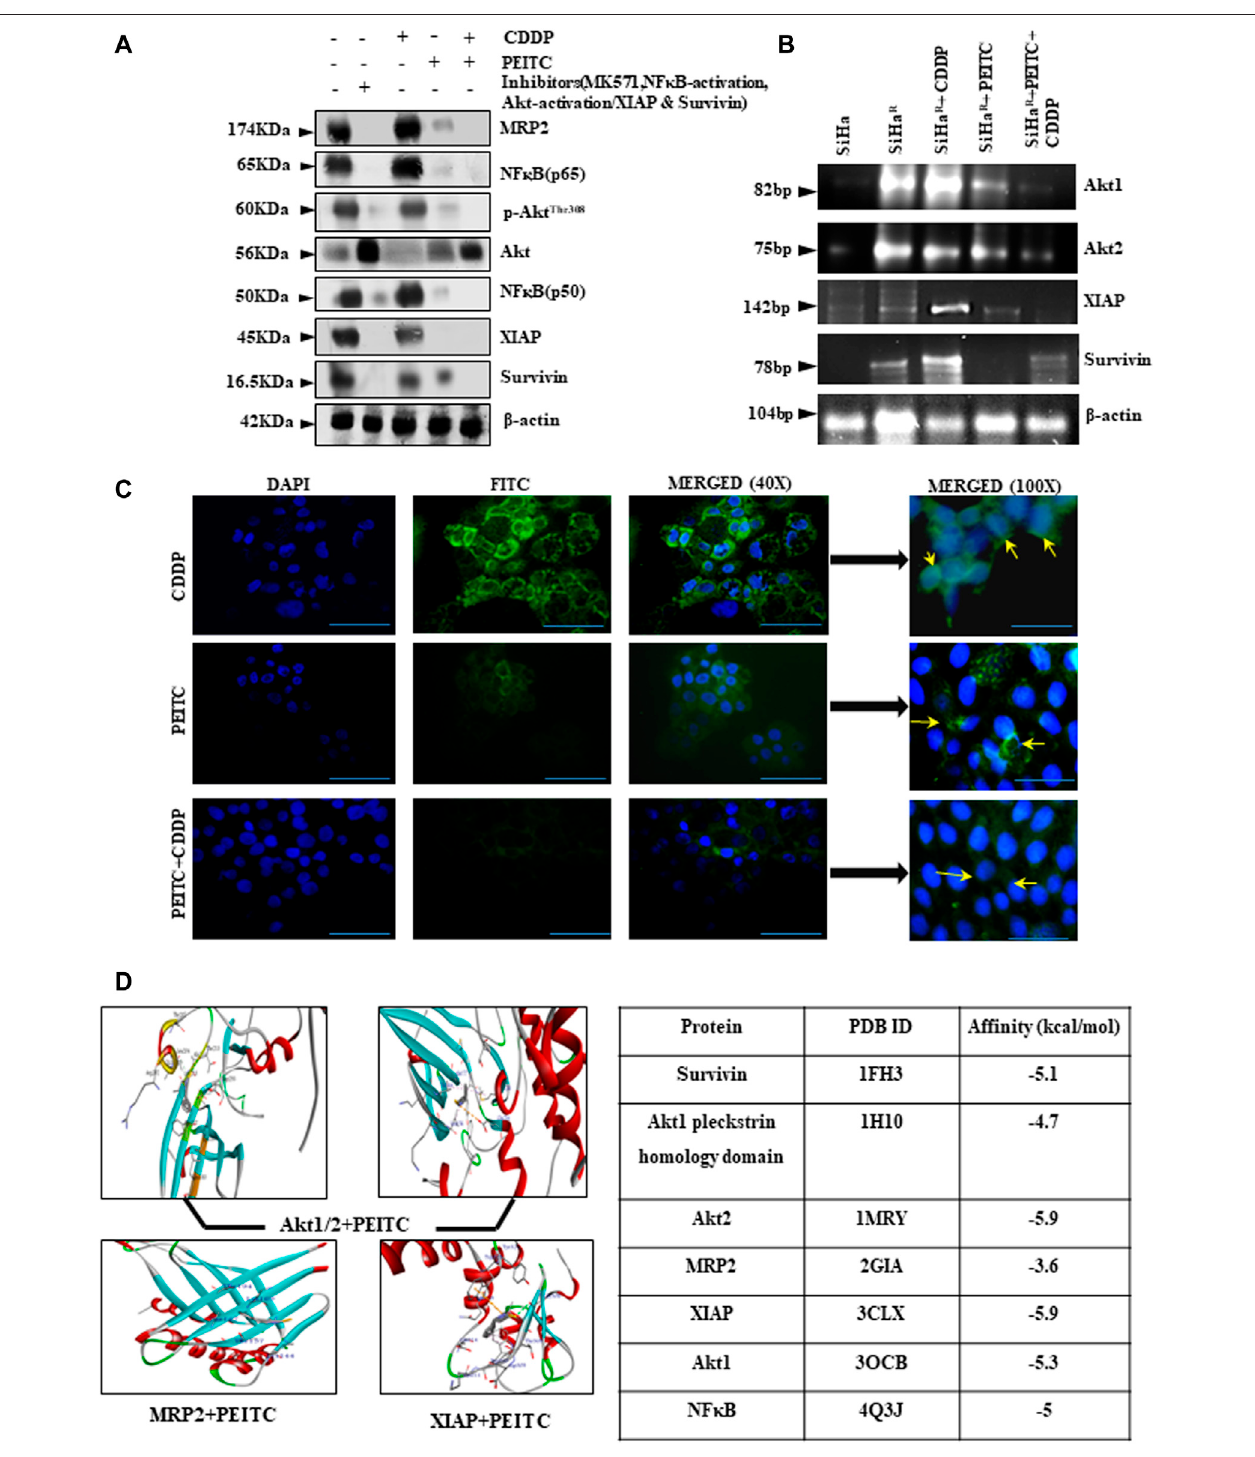
FIGURE 3 | (A) Relative protein expressions of Akt/p-Akt Thr308 , NF- κ B (p50/p65), MRP2, XIAP, and survivin by Western blotting. β -actin was used as a loading control.Respectivebandintensitiesoftheseproteinshavebeenrepresentedgraphicallyin SupplementaryDataS4 . (B) RelativeeffectsofPEITC(pre-treatment)along with CDDP upon Akt and IAP mRNAs asrepresented in the RT-PCR blots. Lane # 1: SiHa, Lane # 2: SiHa R , Lane# 3: SiHa R + CDDP (3.5 µM), Lane # 4: SiHa R + PEITC (0.5 µM), Lane#5:SiHa R +PEITC(0.5 µM)+CDDP (3.5 µM) (C) SpatiotemporaldistributionofMRP2uponsimilar treatmentconditionsinSiHa R and SiHacellsas displayed by indirect immuno fl uorescence data. Main images are magni fi ed up to ×400, while the insets displayed alongside are magni fi ed up to 1,000x. Scale bar of each fi eldmeasurestoabout 50 µm(mainimages)and 20 µm(side-insets).About 50 fi eldswerescannedunderthemicroscopefordataacquisition. (D) AutoDock Vina results highlighting PEITC interaction with Akt, MRP2, and survivin in the best poses. Scores of all the possible interactions have been incorporated in tabular format. Images displaying PEITC interactions with other prosurvival molecules have been provided in Supplementary Data S5 . All experiments were performed in triplicate.